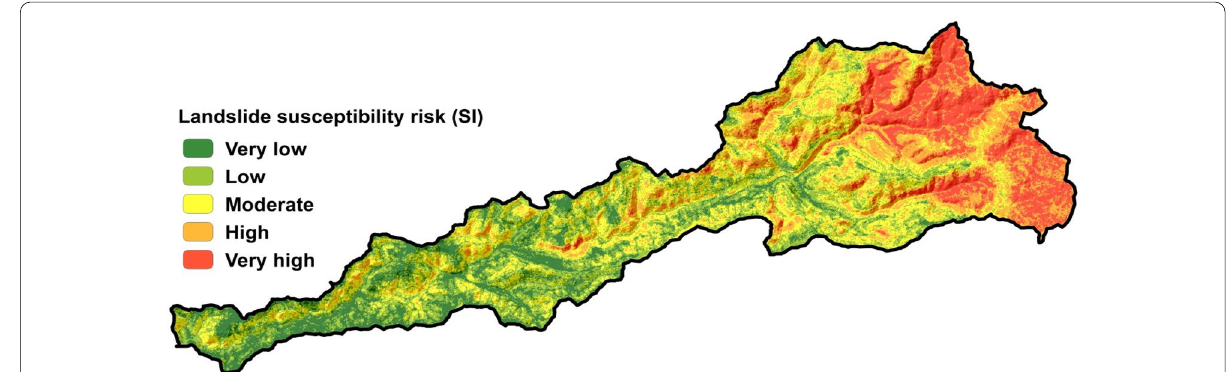
Fig. 5 Landslide susceptibility map in FRB obtained from the SI model